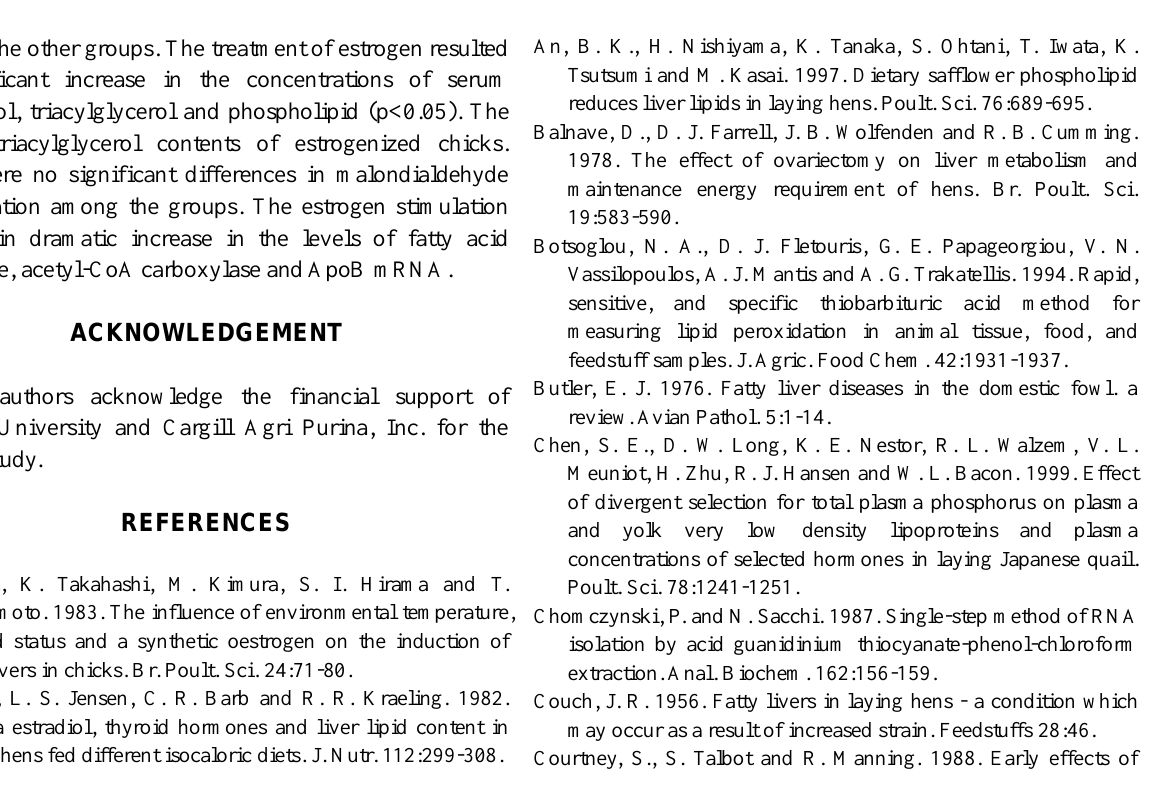
Figure 2. Hepatic mRNA expression. Semi-quantitative RT-PCR analysis. RT-PCR was performed on 1  g of total RNA using fatty acid synthase, acetyl CoA carboxylase, apolipoprotein B and  -actin specific primers as a control for normalization. The relative levels of fatty acid synthetase, acetyl CoA carboxylase and apolipoprotein B expression were determined by normalisation with respect to  -actin expression. T1 = 11.72 MJ/kg diet+low level lipotropic factors; T2 = 12.89 MJ/kg diet+low level lipotropic factors; T3 = 11.72 MJ/kg diet+high level lipotropic factors; T4 = 12.89 MJ/kg diet+high level lipotropic factors; T5 = 11.72 MJ/kg diet+high level lipotropic factors+2 mg/kg BW estradiol benzoate; T6 = 12.89 MJ/kg diet+high level lipotropic factors+2 mg/kg BW estradiol